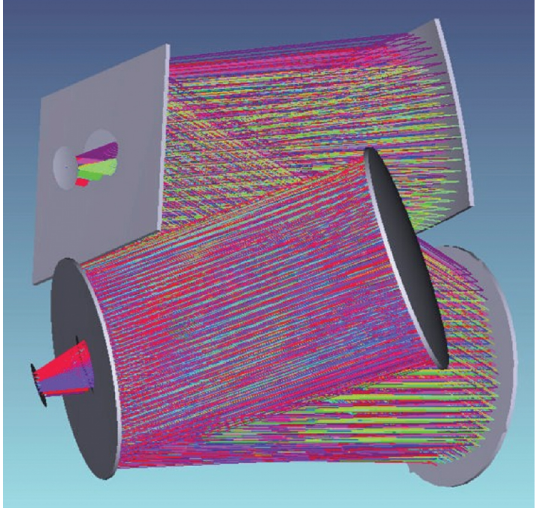
Figure 9: Double Schmidt spectrograph design folded by two flats. Beyond the mask the new spectrograph is based on